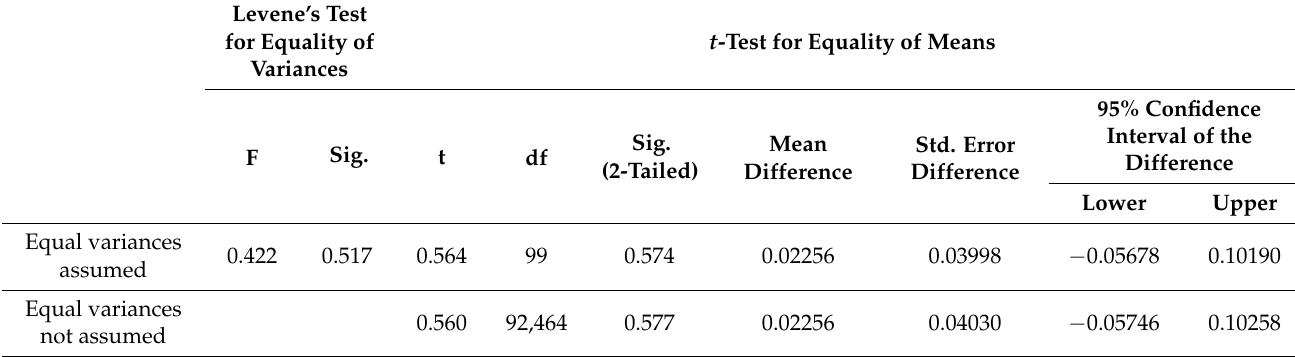
Table 4. A comparison of control group learners’ content knowledge in the pre-and post-tests. The table shows the comparison of scores obtained by learners who did not participate in the recycling project.